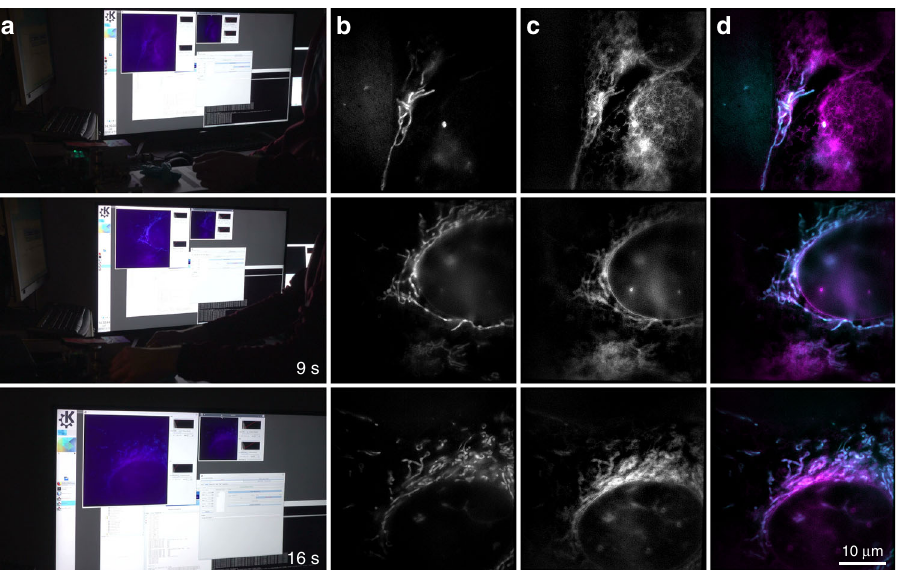
Fig. 3 Demonstration of high-speed live-cell imaging and instant image reconstruction. A typical survey of stained U2OS cells was carried out with our SIM system. Video-recording (full version in Supplementary Movie 1) of the real-time results as presented to the user (column a ), and the SIM reconstructions of the 488 nm channel (column b ), stained for mitochondria (MitoTracker Green), and of the 647 nm channel (column c ), stained for the endoplasmic reticulum (ER-Tracker Red). Column d shows an overlay of both reconstructed channels. Imaging was performed in dual color at 10.4 fps with 2 ms illumination time per raw frame (see Fig. 2b), multiple cells were surveyed in quick succession (see timestamp in each row). SIM allows to clearly